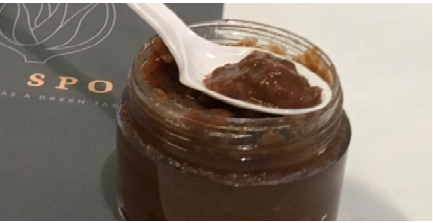
Figure A1. Fruit Compote Visual Appearance. Note: (1) visual appearance did not change between the fruit compotes (Aloe vera gel vs. pectin); (2) no specific labels were used and the jars were the same for the two products. Table A1. Average nutritional contents of the fruit compotes used in the experiments.